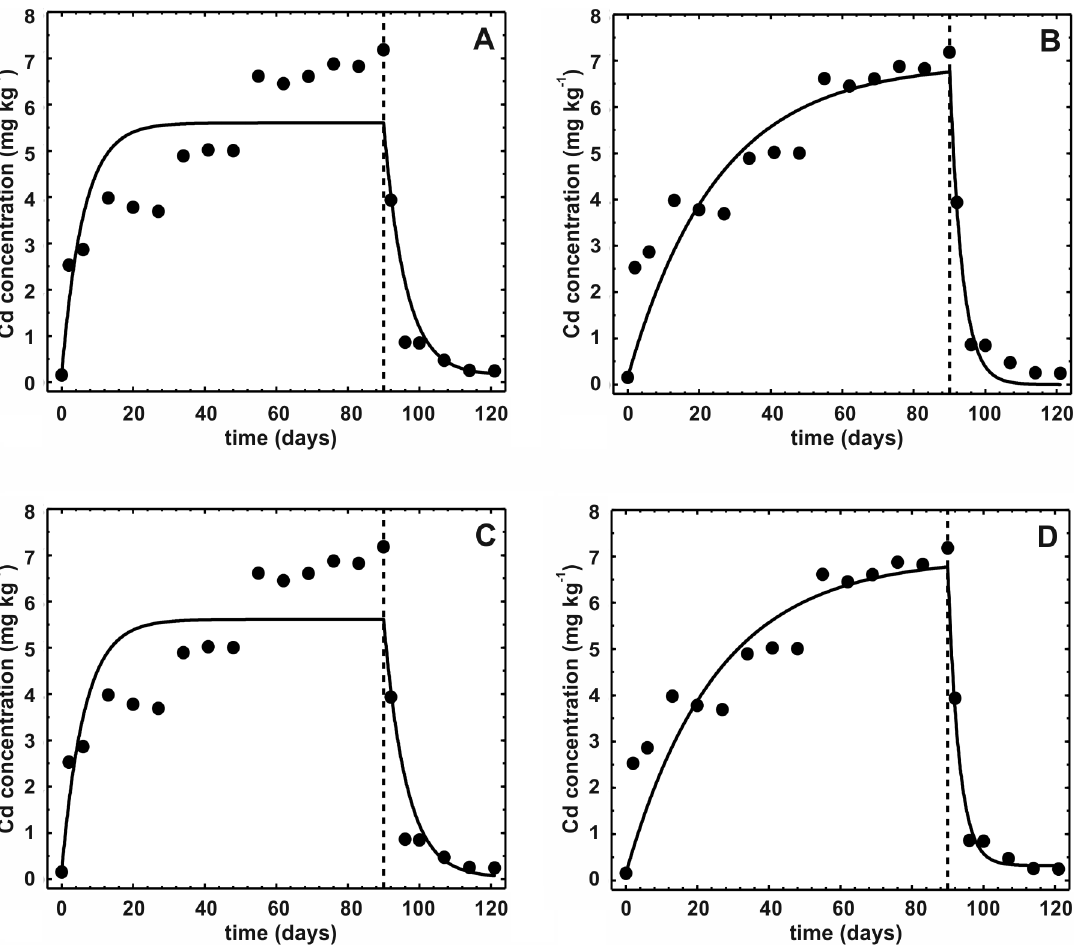
Figure 1. Two-stage toxicokinetic models. Two-stage toxicokinetic models fitted to mean Cd concentrations in the ground beetle Poecilus cupreus (data from Kramarz [2]): a) model by Janssen at al. [4] with constant C I0 =0.15 mg kg 2 1 and C Eu =154.6 mg kg 2 1 ; b) model originally used by Kramarz [2] with C I0 =0.15 mg kg 2 1 and C Eu =154.6 mg kg 2 1 ; c) exact-solution model (Eqs. 8 and 9) with the same uptake and elimination rates in both phases of the experiment, C Eu =154.6 mg kg 2 1 and C Ed =0.92 mg kg 2 1 ; d) exact-solution model with different uptake and elimination rates in the first and second phases of the experiment, C Eu =154.6 mg kg 2 1 and C Ed =0.92 mg kg 2 1 . Vertical broken line indicates the day of changing to uncontaminated food ( t c ).